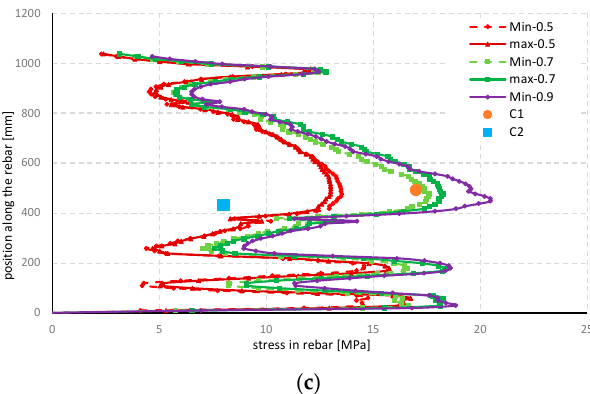
Figure 14. Comparison of numerical and experimental stresses at the rebars in the web: ( a ) Gauges A; ( b ) Gauges B; ( c ) Gauges C.